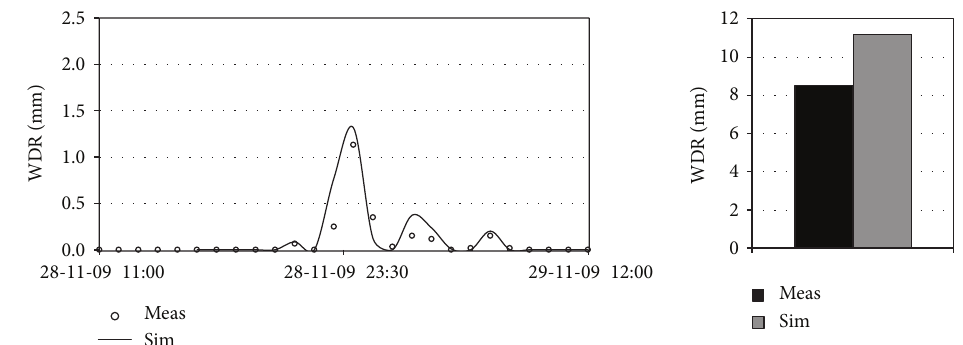
Figure10:VariationintimeandaccumulatedvaluesofWDRonwestfac¸adeinNovember2009(measurementsversusnumericalsimulation).